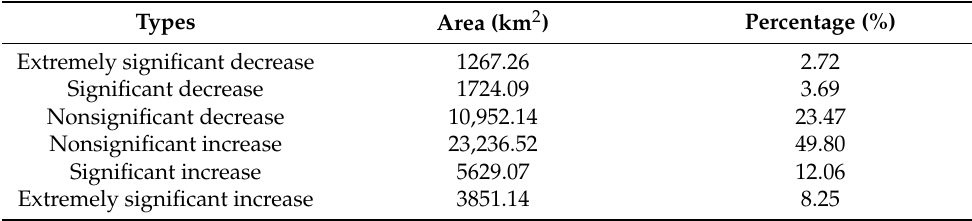
Table 3. Area and proportion of trend significant types of desertification index.